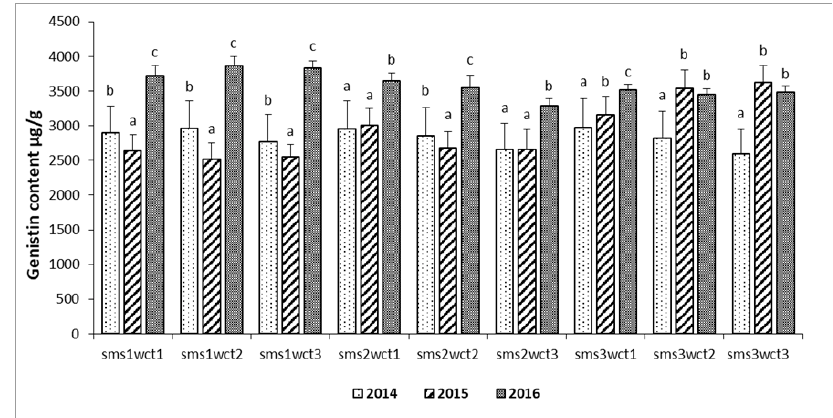
Figure A4. Genistin concentration in soybeans influenced by field year. Sms: soil tillage system and wct: weed control treatment. The values shown are means ± S.E. Different lowercase letters above the bars indicate significant differences in genistin concentration between the years undergoing the same treatment, according to Tukey’s HSD test ( P ≤ 0.05).